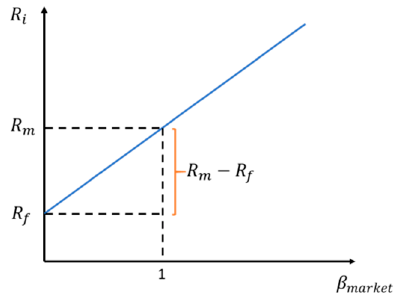
Figure A1. Positive relationship between expected return and market premium.